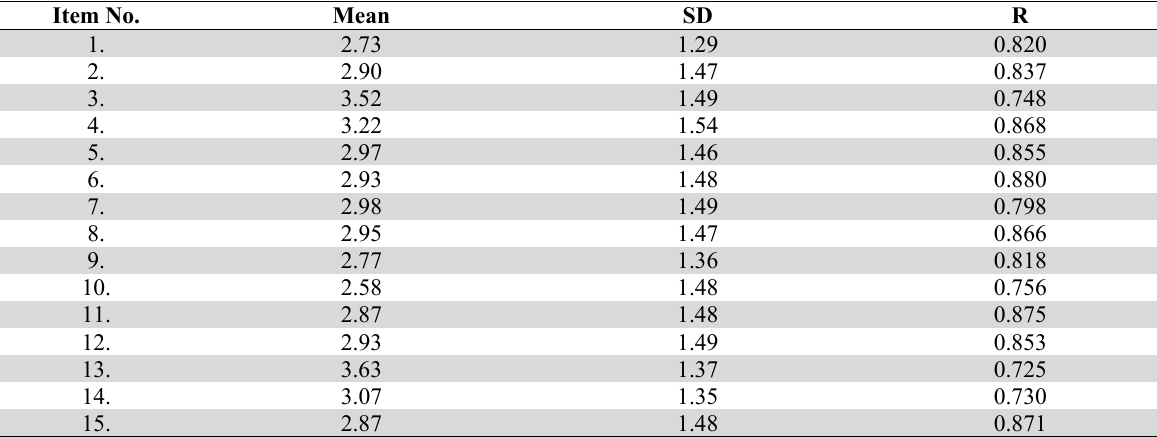
Result of Mean, SD and Item-to-total correlations Item